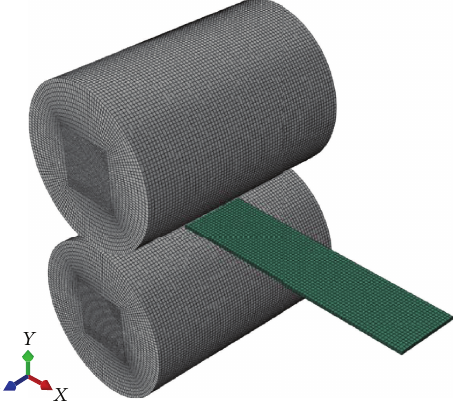
Figure 2: FE model of flexible microrolling.